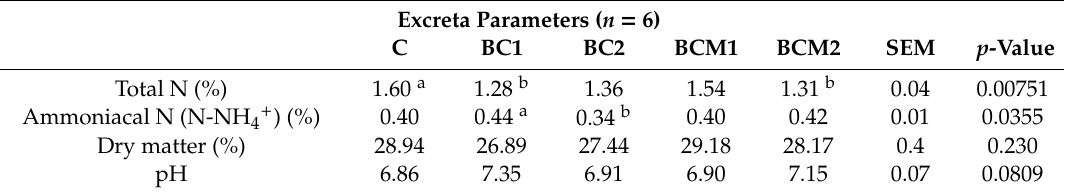
Table 9. Mean excreta parameters from biochar-fed laying